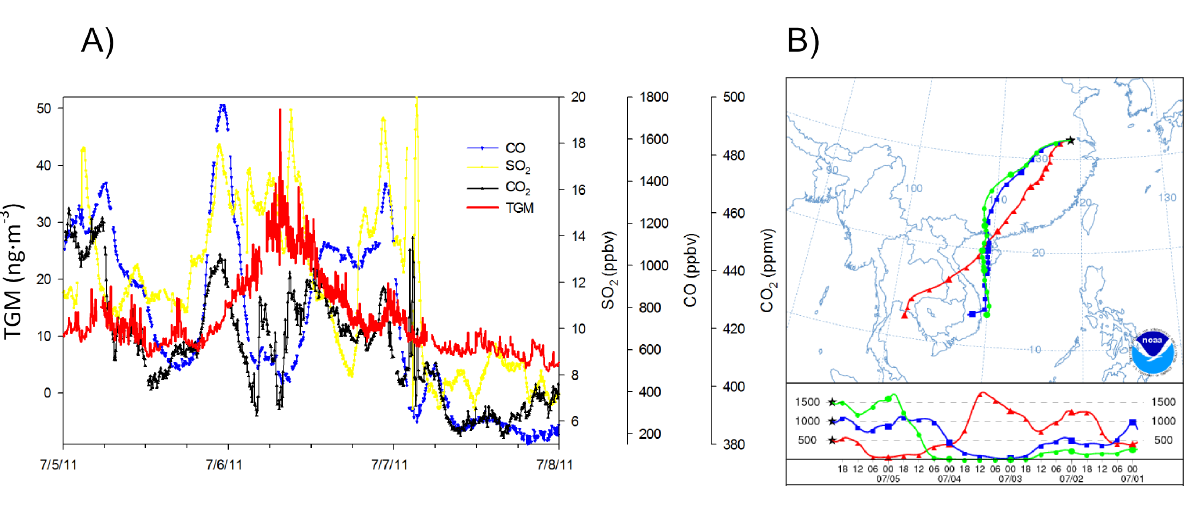
Figure 14. The high TGM episode on 6 July represented in ( A ) time series and ( B ) with the five-day backwards NOAA HYSPLIT plot at 500, 1,000, and 1,500 m.